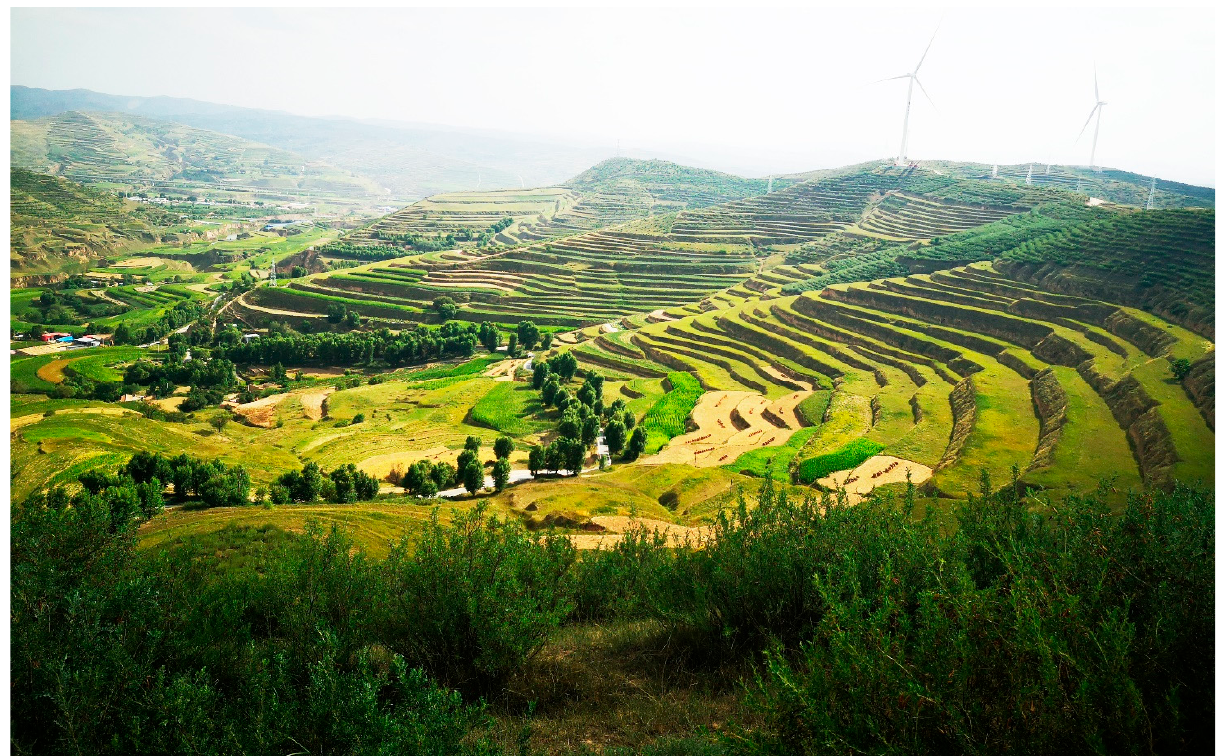
Figure 1. Map showing the location of the study area in Lumacha Village, Lijiabu Town, Anding District of Gansu Province, China.